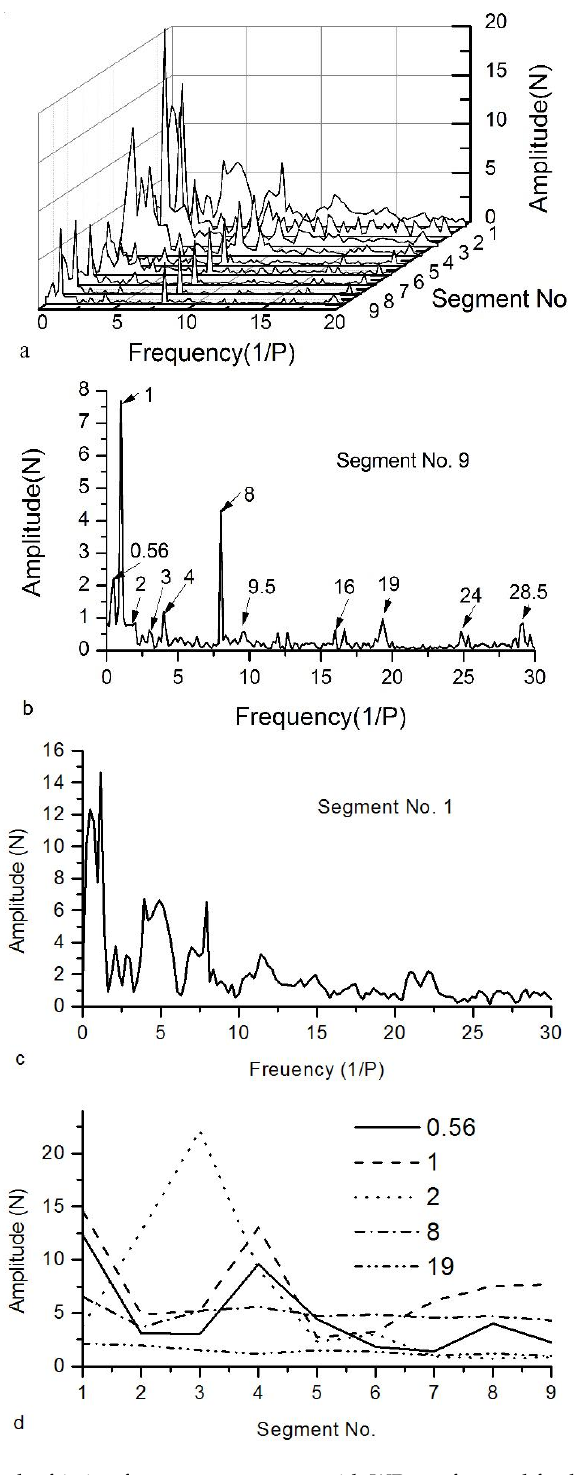
Figure 9. Variations in the friction frequency spectrum with WP at a forward feed of 5 mm / min. ( a ) FFS of all segments; ( b ) FFS of segment No. 9; ( c ) FFS of segment No. 1; ( d ) Amplitude of all segments for significant frequency components.